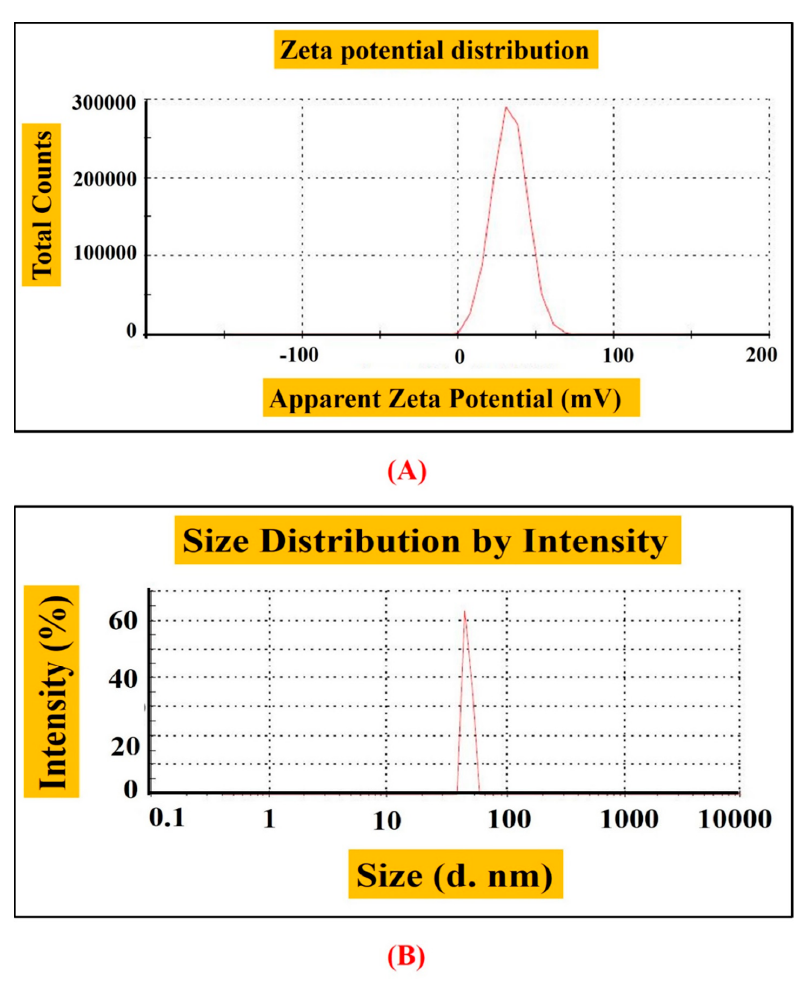
Figure 3. ( A ) Zeta potential of NiONPs ( B ) Size distribution of RT-NiONPs.